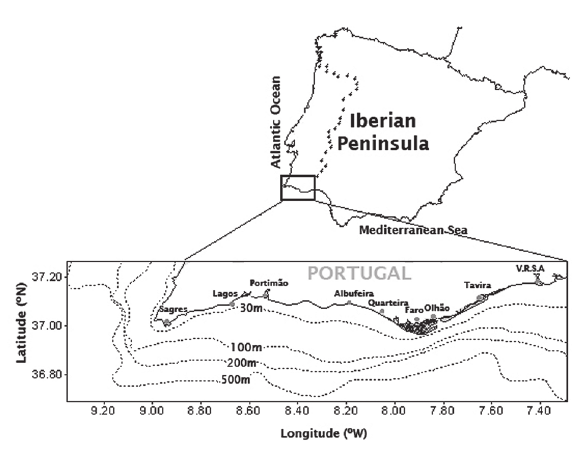
Fig . 1. – algarve region, showing the main fishing ports in the re-